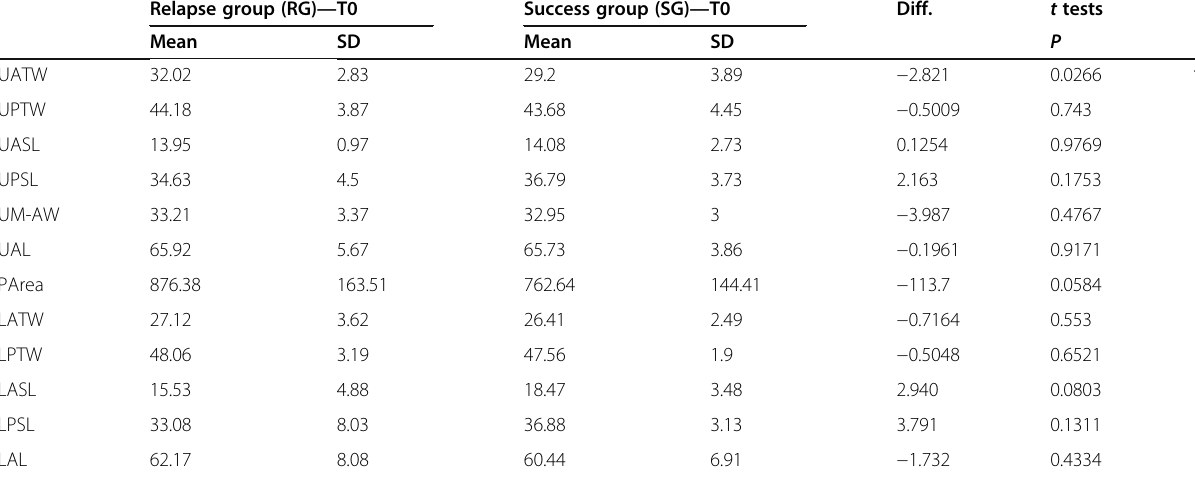
Table 5 Statistical comparisons between groups at T0: digital dental casts measurements Relapse group (RG) — T0 Success group (SG) — T0 Diff.